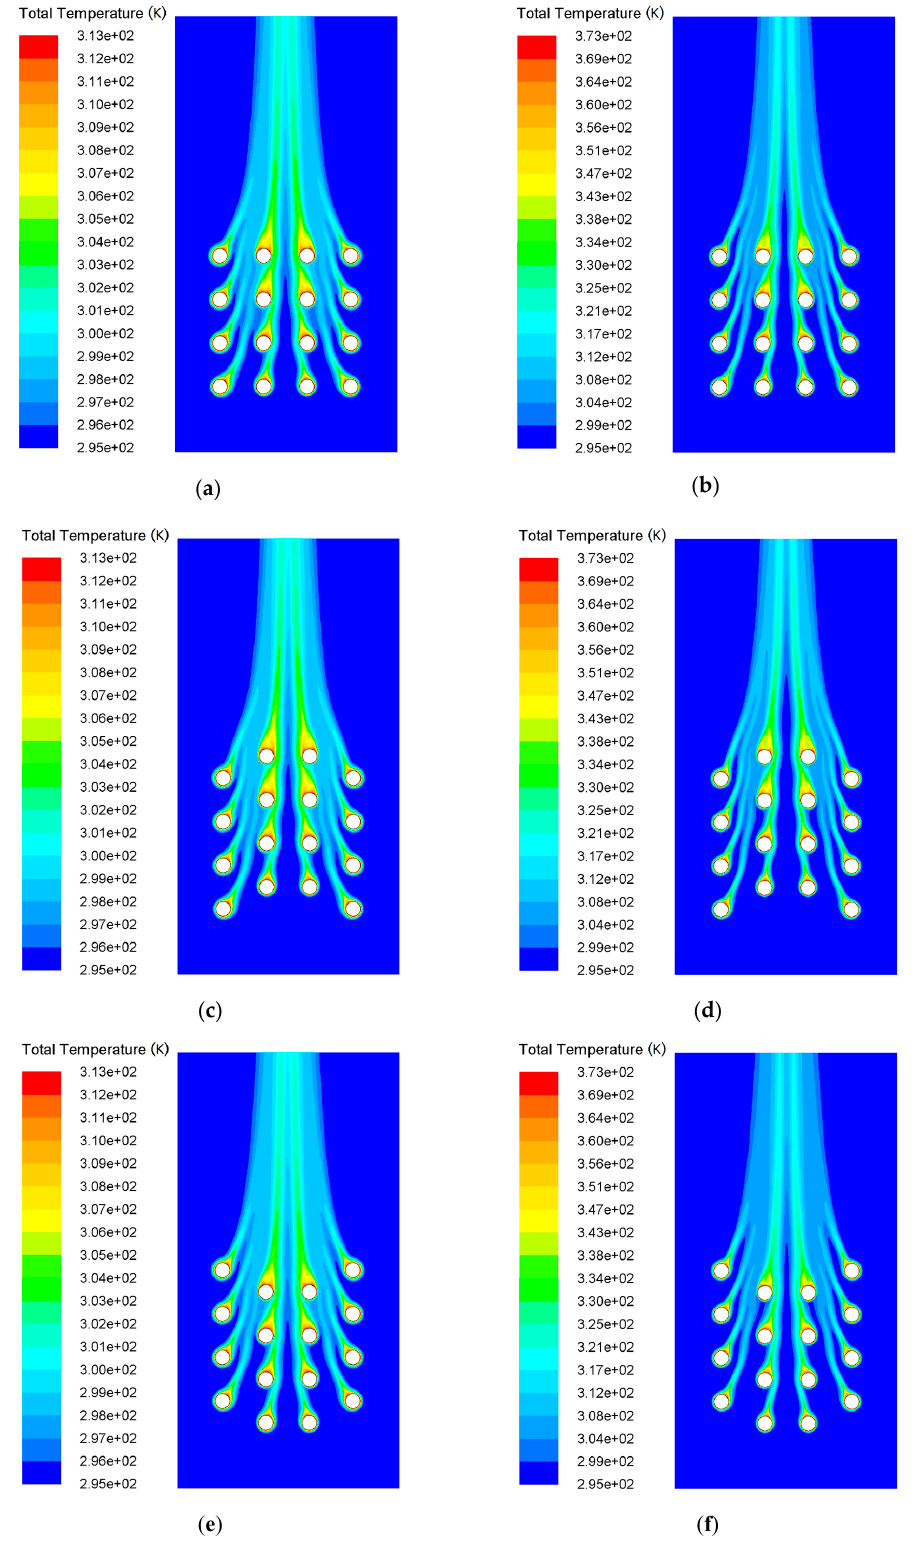
Figure 16. The temperature fields of the tube arrays 4 × 4 with the tube ratio spacing S / D = 3: ( a ) base configuration at Ra = 1.3 × 10 4 ; ( b ) base configuration at Ra = 3.7 × 10 4 ; ( c ) concave configuration at Ra = 1.3 × 10 4 ; ( d ) concave configuration at Ra = 3.7 × 10 4 ; ( e ) convex configuration at Ra = 1.3 × 10 4 ; ( f ) convex configuration at Ra = 3.7 × 10 4 .